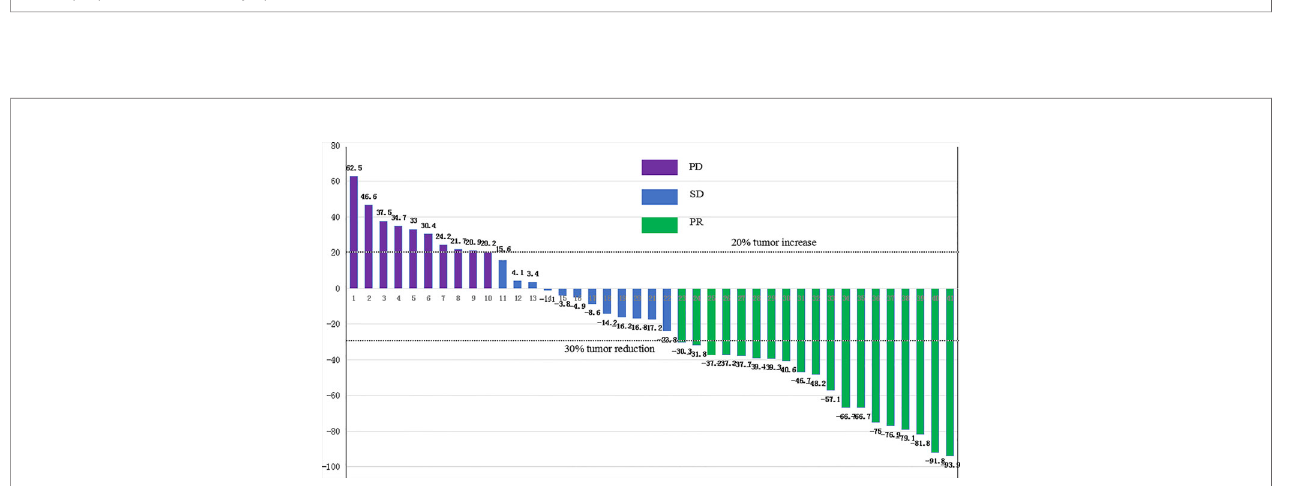
FIGURE 4 | The waterfall diagram of tumor ef fi cacy. PR, partial response; SD, stable disease; PD, progression